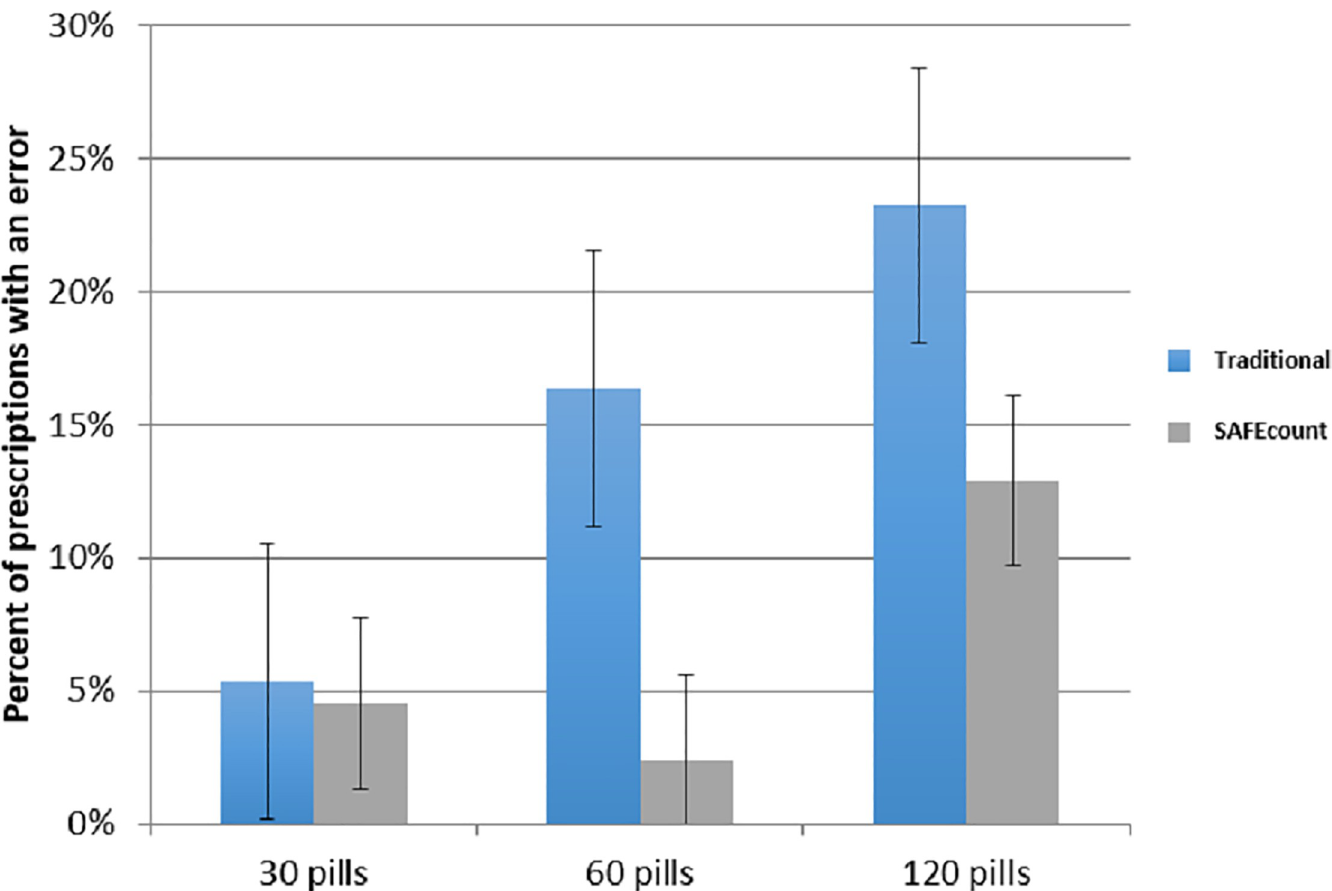
Fig 2. Percent of prescriptions with an error by prescription volume and counting